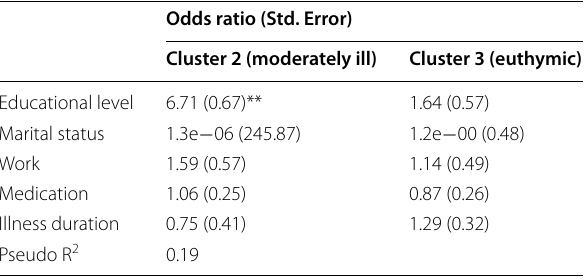
Odds ratio’s and standard errors. Base outcome (reference category) cluster 1: severely ill. **p < 0.01 Table 5 Regressing Entropy on a selection of covariates (n Variable Beta Std. error Pr. ( >|t|)